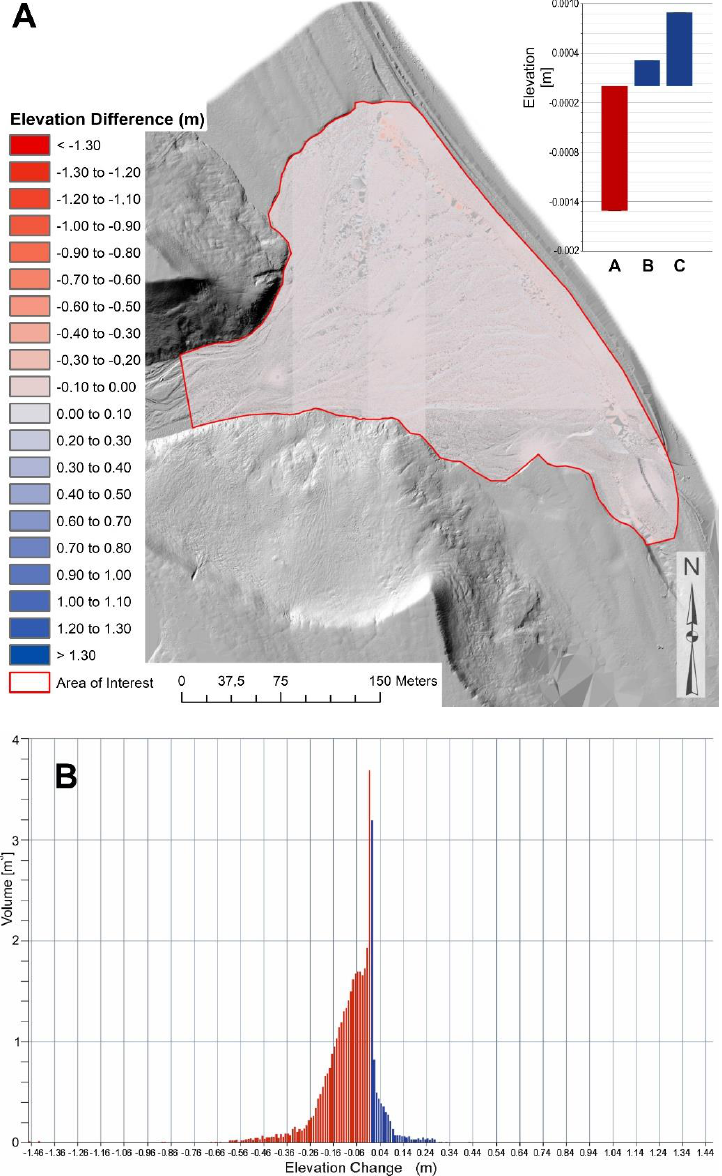
Figure 7. ( A ) DEM of difference (DoD) for the AoI (July 2013 with MinLoD = 0). Hillshade map is shown behind the DoD for context. ( B ) Histograms of volume and area changes of AoI. Description of the bars in the diagram: (A) Average Depth of Lowering; (B) Average Depth of Raising; (C) Average Total Thickness Difference.